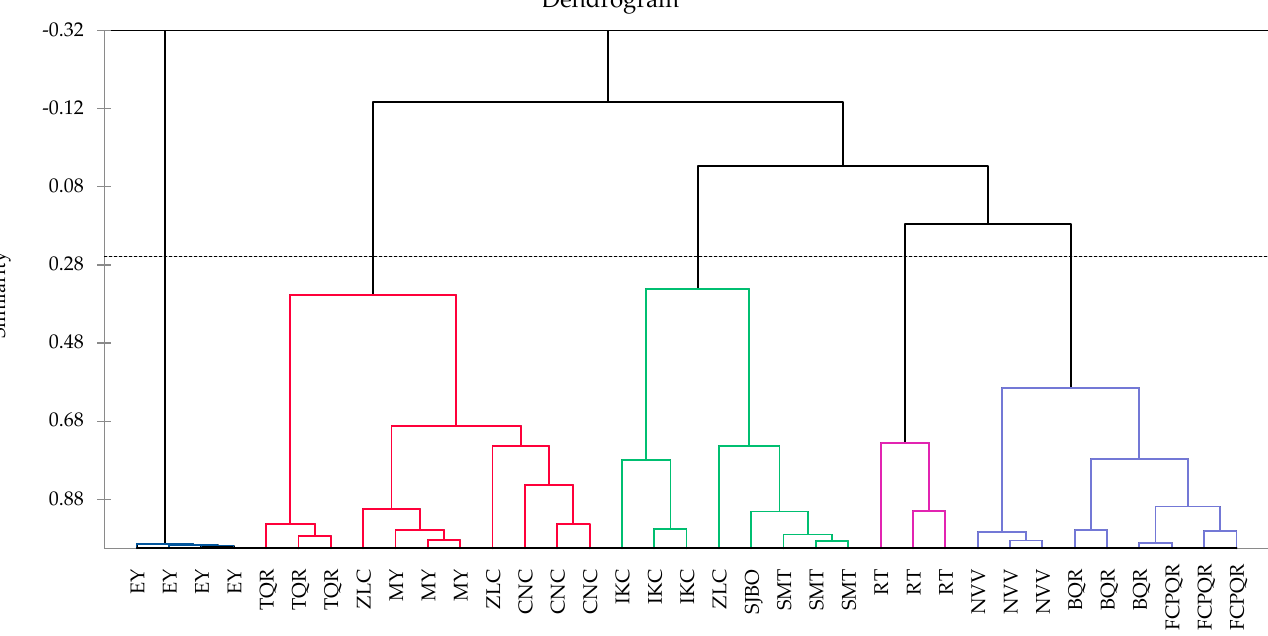
Figure 1. Dendrogram from Agglomerative Hierarchical Cluster Analysis of 35 propolis samples using phenolic and flavonoid contents, and in vitro assays of antioxidant, anti-inflammatory, and antibacterial properties. EY = Espita, Yucatan; MY = Mama, Yucatan; CNC = Centauros del Norte, Campeche; IKC = Ich-Ek, Campeche; ZLC = Zoh-Laguna, Campeche; BQR = Bacalar, Quintana Roo; FCPQR = Felipe Carrillo Puerto, Quintana Roo; TQR = Tihosuco, Quintana Roo; RT = Reforma, Tabasco; SMT = San Marcos, Tabasco; NVV = Ejido Nicol á s Bravo, Veracruz; SJBO = San Juan Bautista,